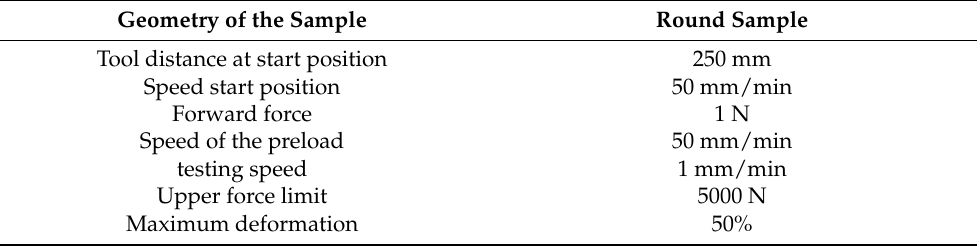
Table 3. Parameters for the compression tests. Geometry of the Sample Round Sample Tool distance at start